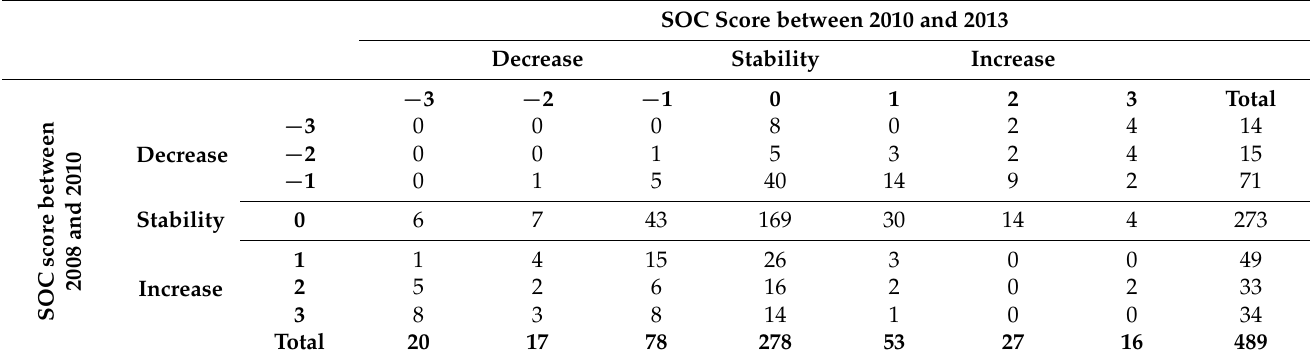
Table 2. Percentiles distribution of SOC among the participants during the years of follow up. SOC Score between 2010 and